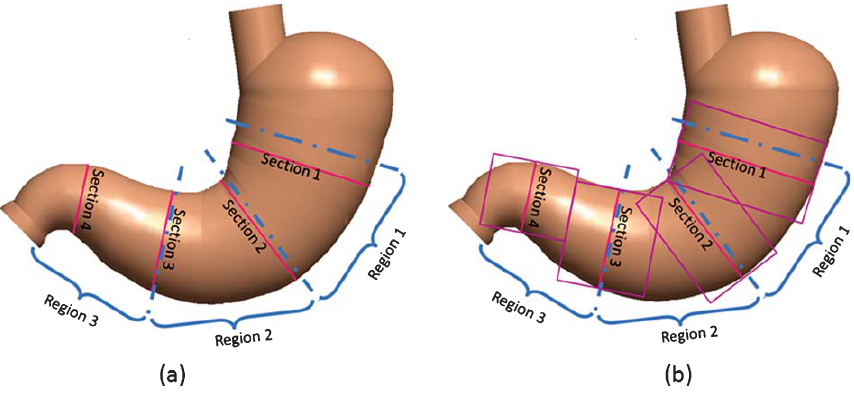
Fig. 5. (a) Stomach regions and sections in correspondence to the positioned cables. (b) Cylindrical volume modelled for each contraction